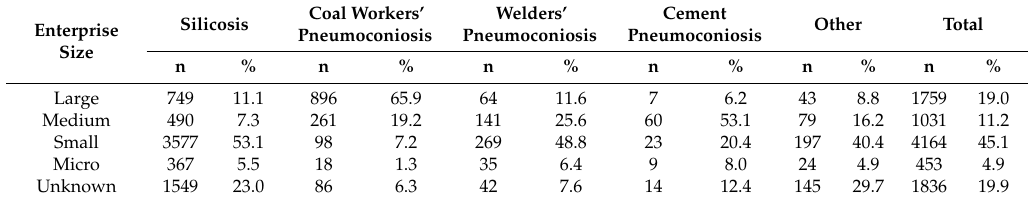
Table 3. The enterprise scale distribution of pneumoconiosis cases reported from 2006 to